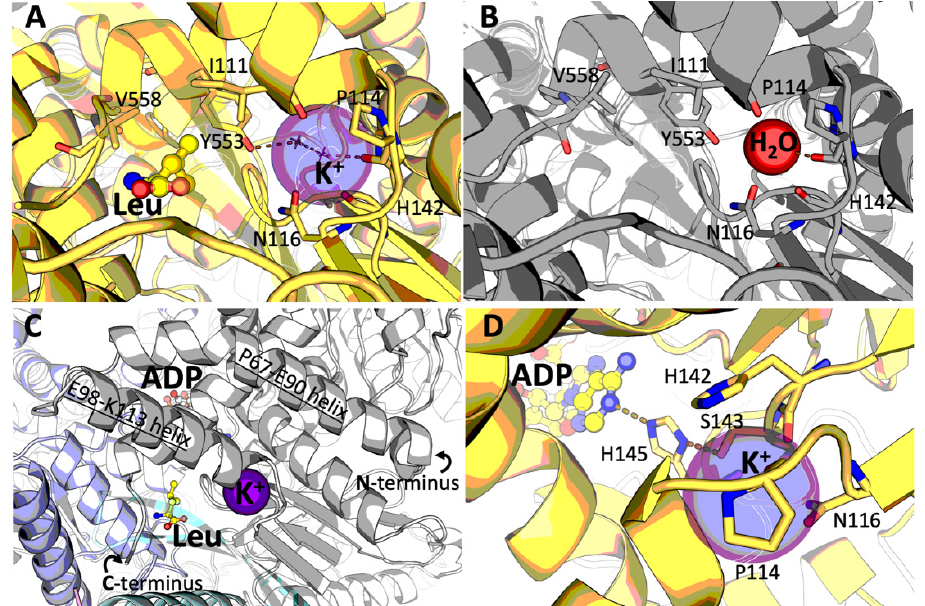
Figure 4. K + binding site in mammalian GDH. ( A )—The K + binding in the GDH ∙ ADP ∙ Leu complex, colored as in Figure 2A. The interaction of K + and leucine through Y553 and a water molecule from the coordination sphere of K + is shown. ( B )—The same site in the GDH ∙ ADP complex (colored as in Figure 2B), where the potassium ion is modeled to be substituted by water. ( C )—Relative positions of the leucine, ADP and potassium binding sites at the interface of GDH trimers, colored as in Figure 1. ( D )—Interaction between the K + and ADP binding sites. The ADP binding modes are equivalent in both the GDH ∙ ADP ∙ Leu and the GDH ∙ ADP complexes described here. H-bonds are shown as dashed lines. All indicated residues belong to one chain.